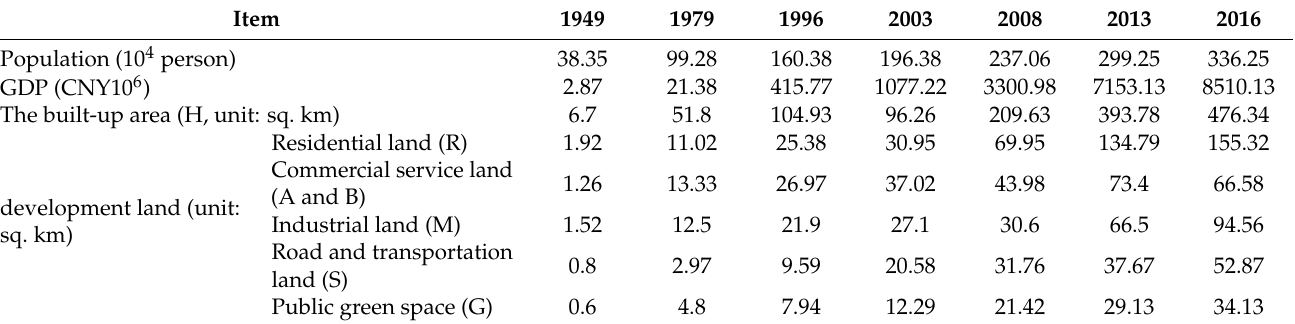
Table 1. Population, economic and built-up area